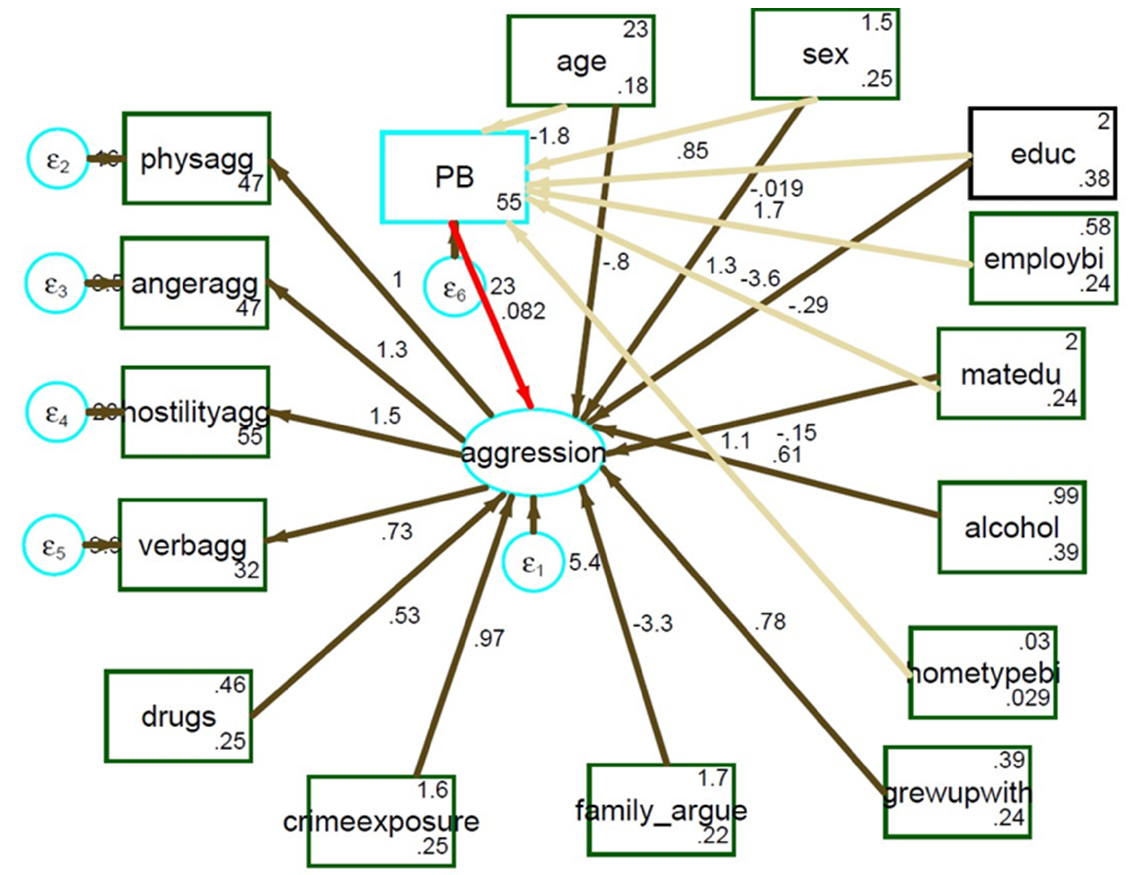
Figure 1. Path analysis between PB, aggression and study predictors. (Fit statistics: χ 2 (model vs. saturated) = 48.403 (0.337); RMSE = 0.028 (pclose 0.736); CFI = 0.970; TLI = 0.957; SRMR = 0.048 and coefficient of determination = 0.43) (matedu = maternal education; hometypei = type of housing; family argue = exposure to family violence; crimeexposure = crime and violence in neighbourhood; employbi = occupational status).